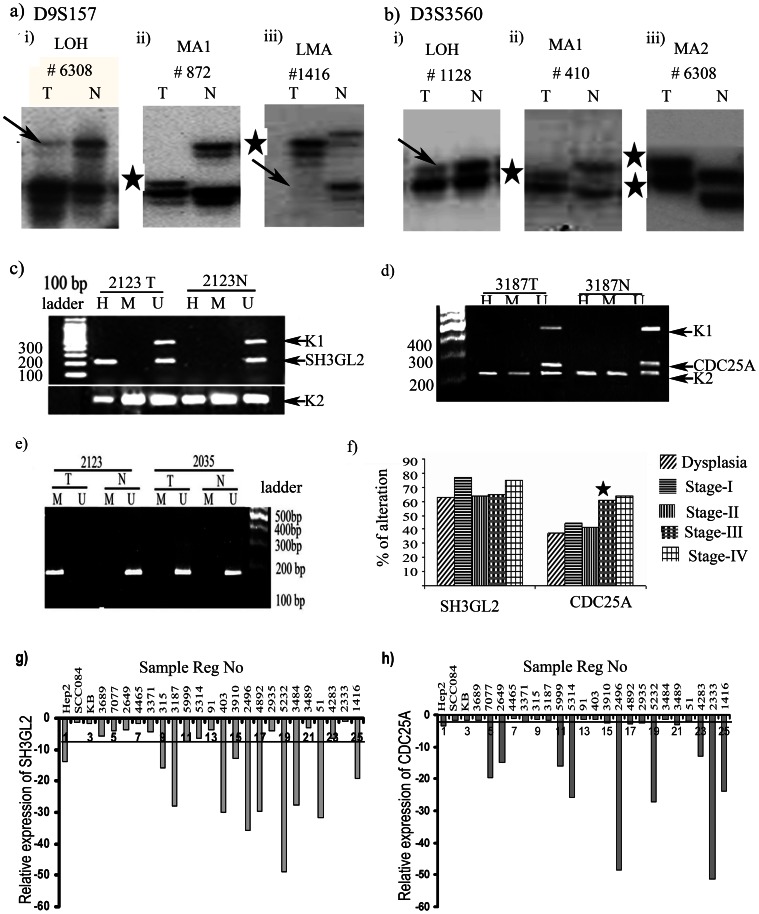
Molecular alterations of SH3GL2 and CDC25A.a) Representative autoradiographs showing deletion and MA in HNSCC samples at D9S157 marker loci. (i) LOH, loss of heterozygosity, (ii) MA-I, microsatellite size alteration of one allele, (iii) LMA microsatellite size alteration of of one allele and LOH in other allele. b) Genetic alterations of CDC25A analyzed by microsatellite based deletion mapping showing deletion and MA in HNSCC at D3S3560 marker loci (i) LOH loss of heterozygosity, (ii) MA-I microsatellite size alteration of one allele. (iii) MA2 microsatellite size alteration of both alleles. Arrow heads indicate the lost allele and star indicates the allele with MA. Representative gel electrophorogram showing the methylation status of c) SH3GL2 and d) CDC25A in tumor samples and in corresponding normal sample by MSRA. SH3GL2 showed methylation in tumor sample and absence of methylation in adjacent normal samples. Promoter methylation of CDC25A was absent in both tumor and normal samples. h, amplicon obtained with primer for HpaII digested DNA; m, amplicon obtained with primer for MspI digested DNA; u, amplicon obtained with primer for undigested DNA. e) The methylation analysis by MSRA was validated by MSP after bisulphate modification of DNA. The sample #2123T showed the methylalaton specific PCR band, but #2123N and #2935TN showed unmethylation specific PCR band. U; amplicon obtained with primer for modified unmethylated DNA, M amplicon obtained with primer for modified methylated DNA, T tumor DNA, N corresponding normal tissue DNA. f) Frequency of overall alterations of the genes SH3GL2 and CDC25A observed in dysplasia and different stages of HNSCC samples. Significant increase in alteration with tumor progression is shown by asterisk. Q-RT PCR showing reduced expression of g) SH3GL2 and h) CDC25A in HNSCC tumor. Bars represented the gene expression normalized to β2-microglobulin and relative to adjacent normal tissues using the 2?-ddCt method. The line illustrates the mean decreased level of the genes. X-axis indicates samples.